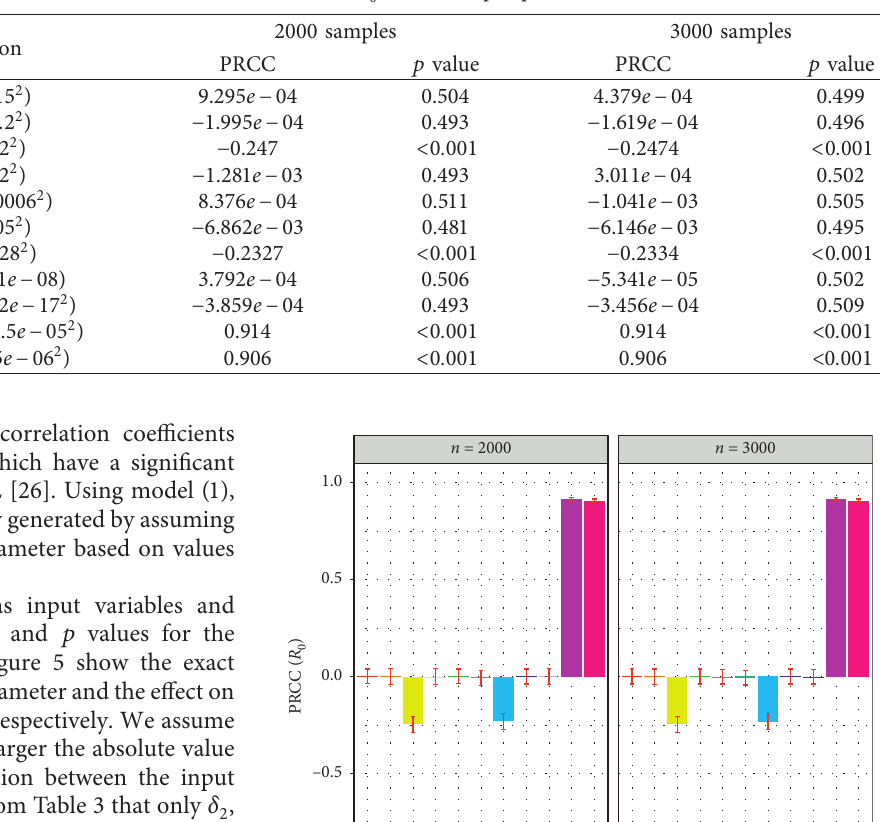
Table 3: Partial rank correlation coefficients (PRCCs) for R